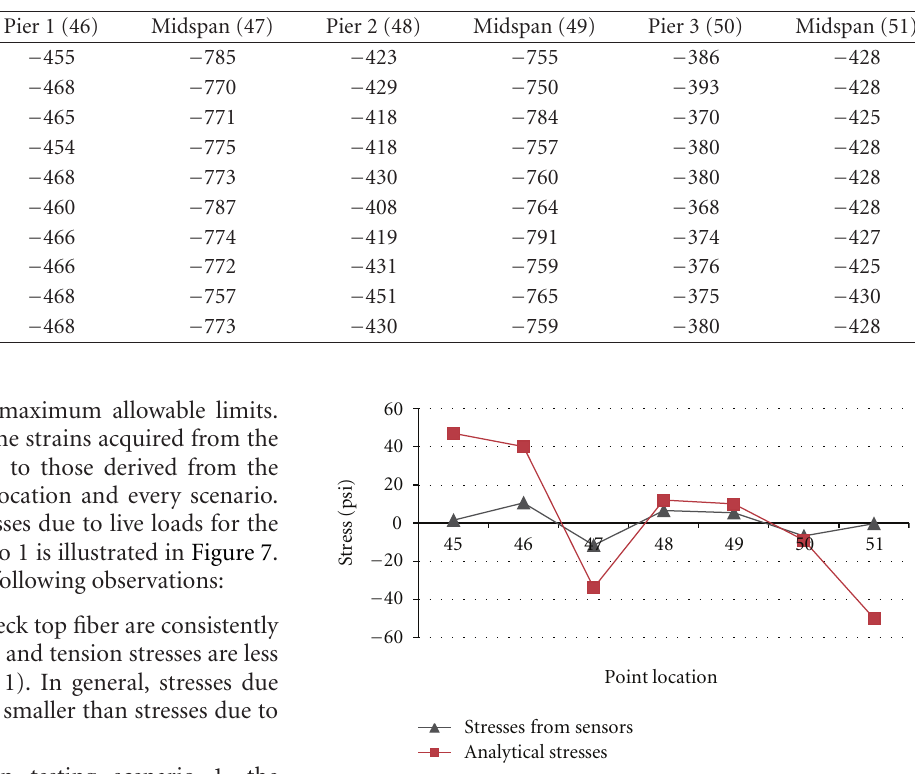
Figure 7: Comparison of analytical stresses and sensor stresses— south panels in testing scenario